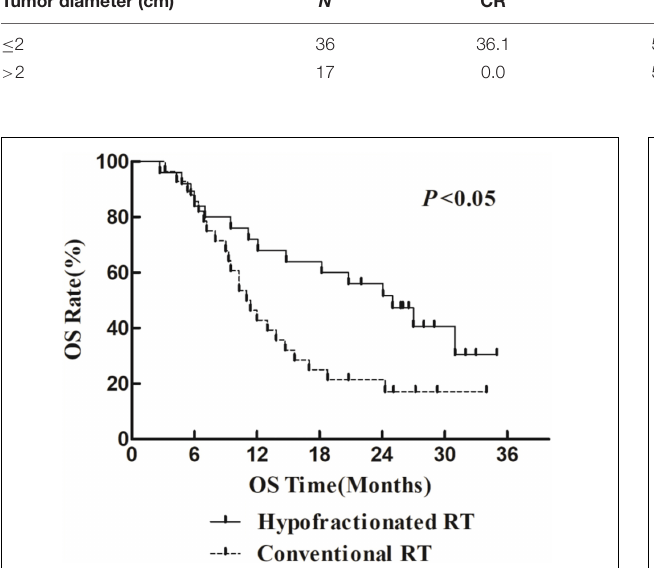
TABLE 4 | Comparison of short-term efficiency in patients with a lymphatic metastatic lesion of different diameters. Tumor diameter (cm) N CR